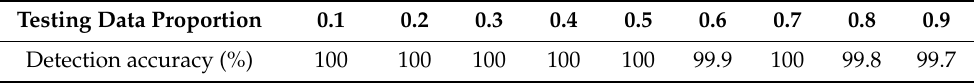
Table 3. Fault detection accuracy of convolutional neural networks